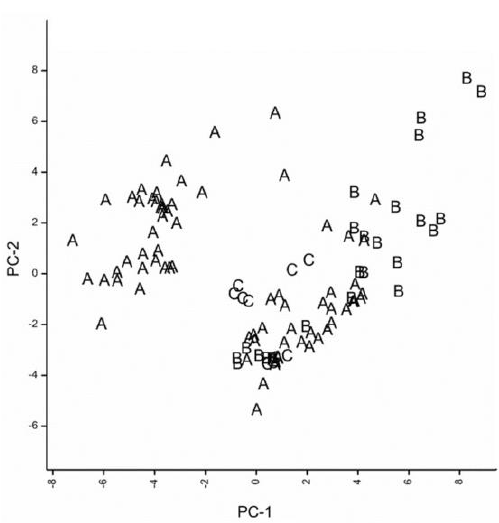
Figure 2. Principal components of Leptocybe spp. collection records grouped according to lineage, i.e. A (Lineage A invasive), B (Lineage B invasive), and C (Lineage B endemic).